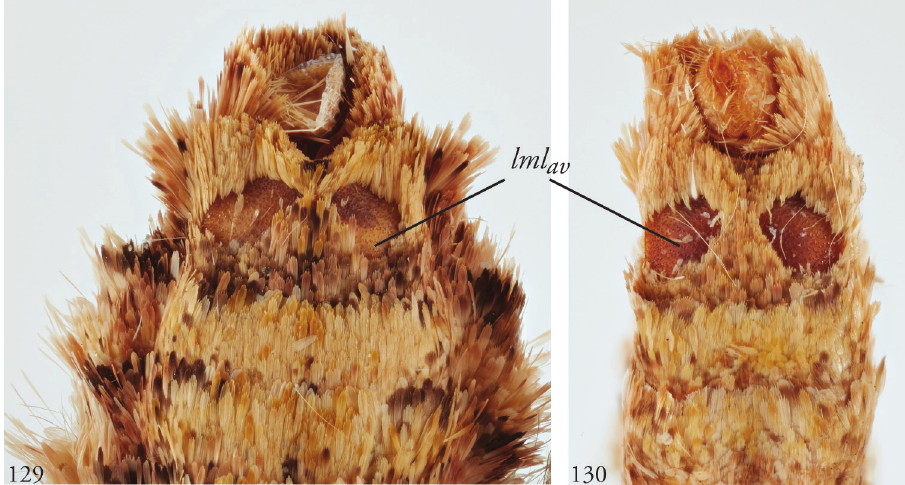
Figures 129–130. Female abdomen, ventral aspect, illustrating paired sternal sclerotizations in two specimens of the Leucosigma chloe complex. 129 MEX: Tmps Gomez Farias 21 III 1981, Nacimiento del Rio Frio, Gillespy & Lara Collectors; USNMENT01437352 130 Bocas dToro Pan, Apr ‘07, Collection Wm Schaus;